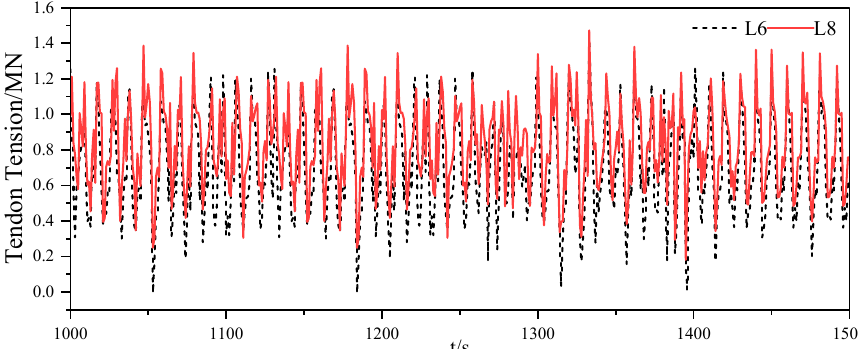
Figure 28. Tendon tension of L4 and L6 when the inclined angle is 30°.